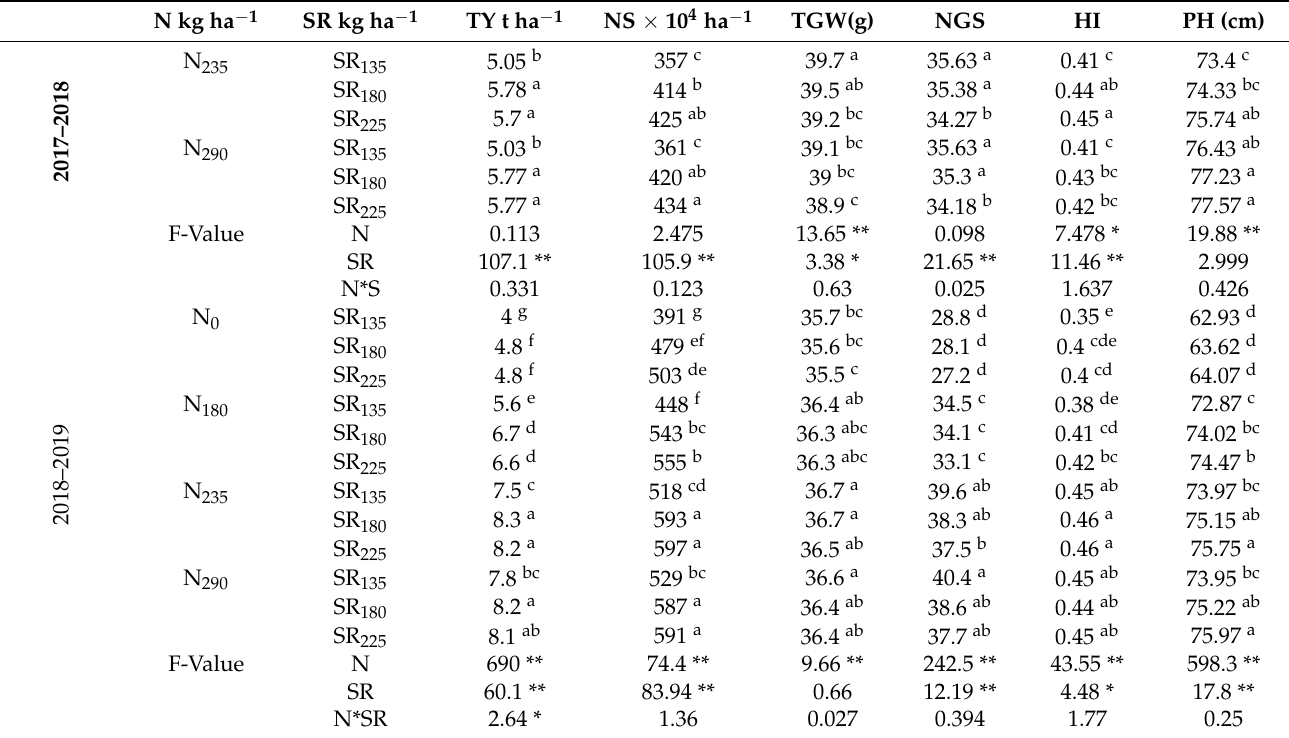
Table 1. Effects of N and SR on GY and agronomic characteristics in 2017–2018 and